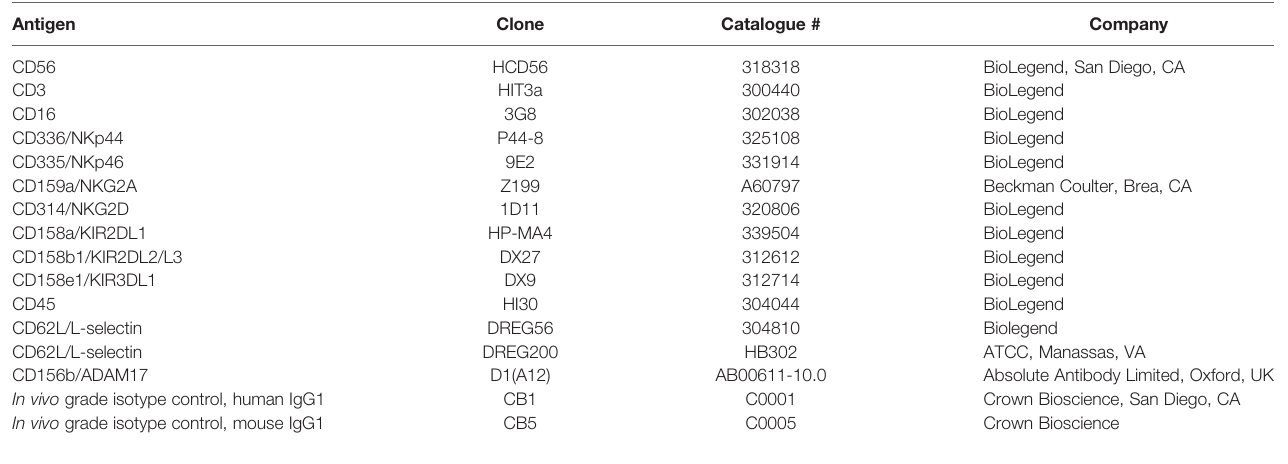
TABLE 1 | Description of the commercial antibodies used in this study.